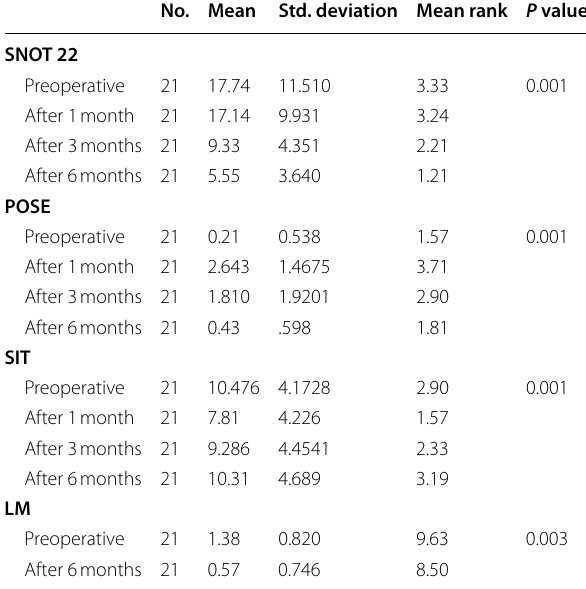
Table 2 Friedman test showed differences between ranks of measured dependent variables according to some measured variables and the time of